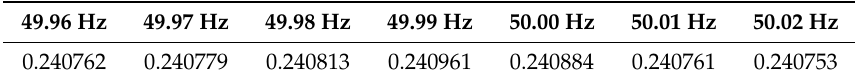
Figure 7. The phase space tracks of different driving force frequencies for IMF7.